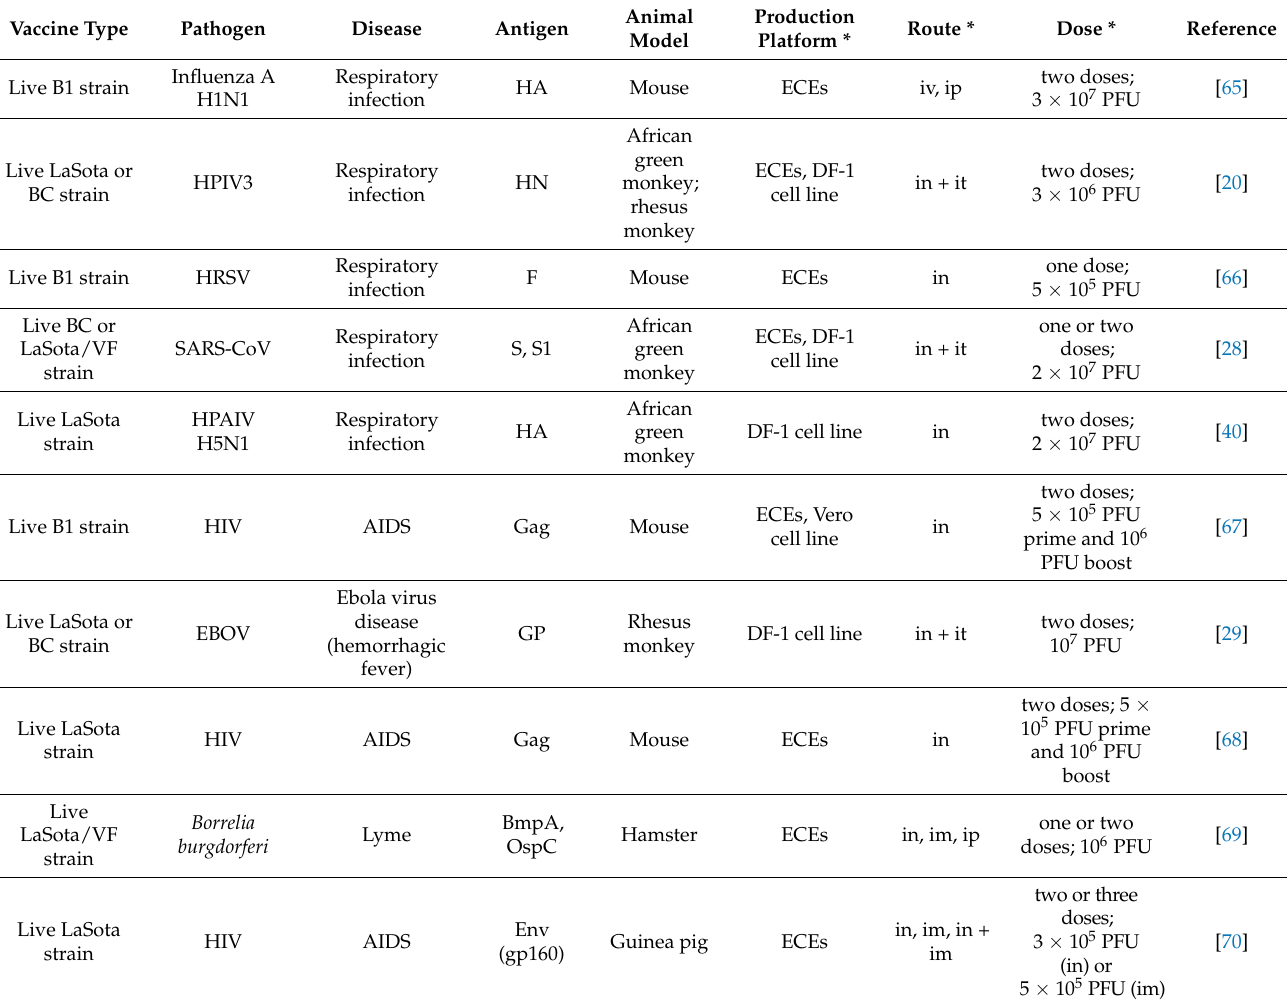
Table 1. NDV-vectored vaccine candidates for human use in chronological order (publication